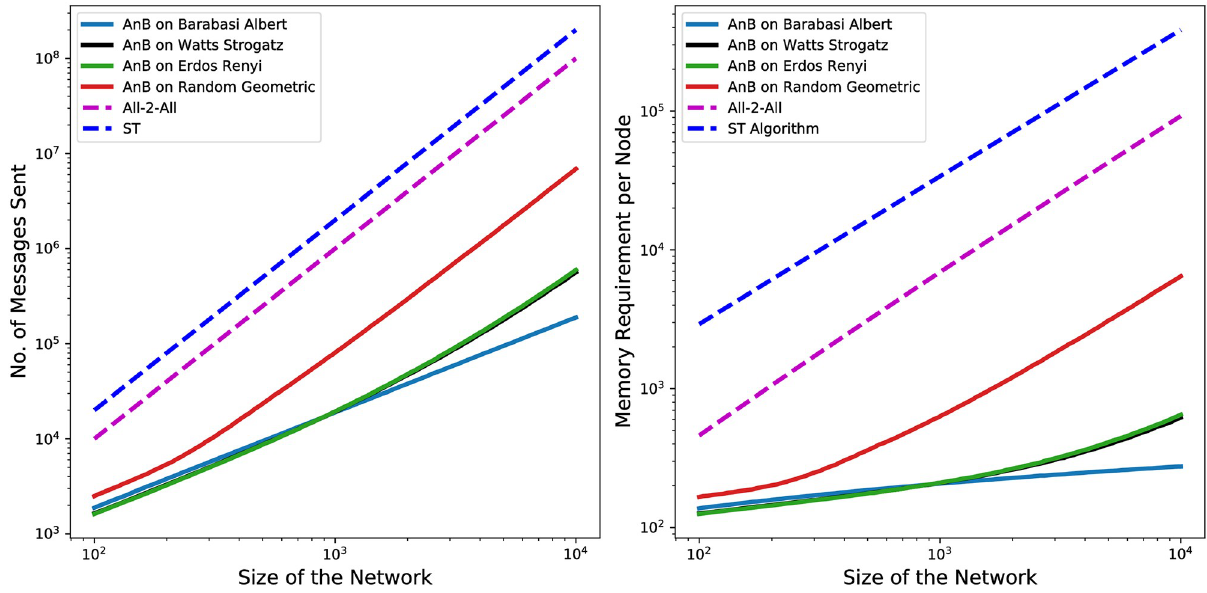
Fig 4. The AnB is the most efficient algorithm in terms of communication and memory costs, compared with the All-2-All and ST algorithms. The left panel shows the total number of messages sent by the nodes. The right panel shows the corresponding memory requirements per node with average connectivity degree d . In both panels, the dashed lines show the scaling for the All-2-All and ST algorithms, whereas the solid lines of various colors show the scaling for the AnB algorithm. Note that the number of messages sent and the memory requirements depends only on the network size for All-2All and ST algorithms and hence, are independent of the network topology. However, the number of messages sent and the memory requirements for AnB algorithm depends on the number of residue nodes which in turn depends on the topology of the network. Therefore, their dependence on the network topology is also explicitly